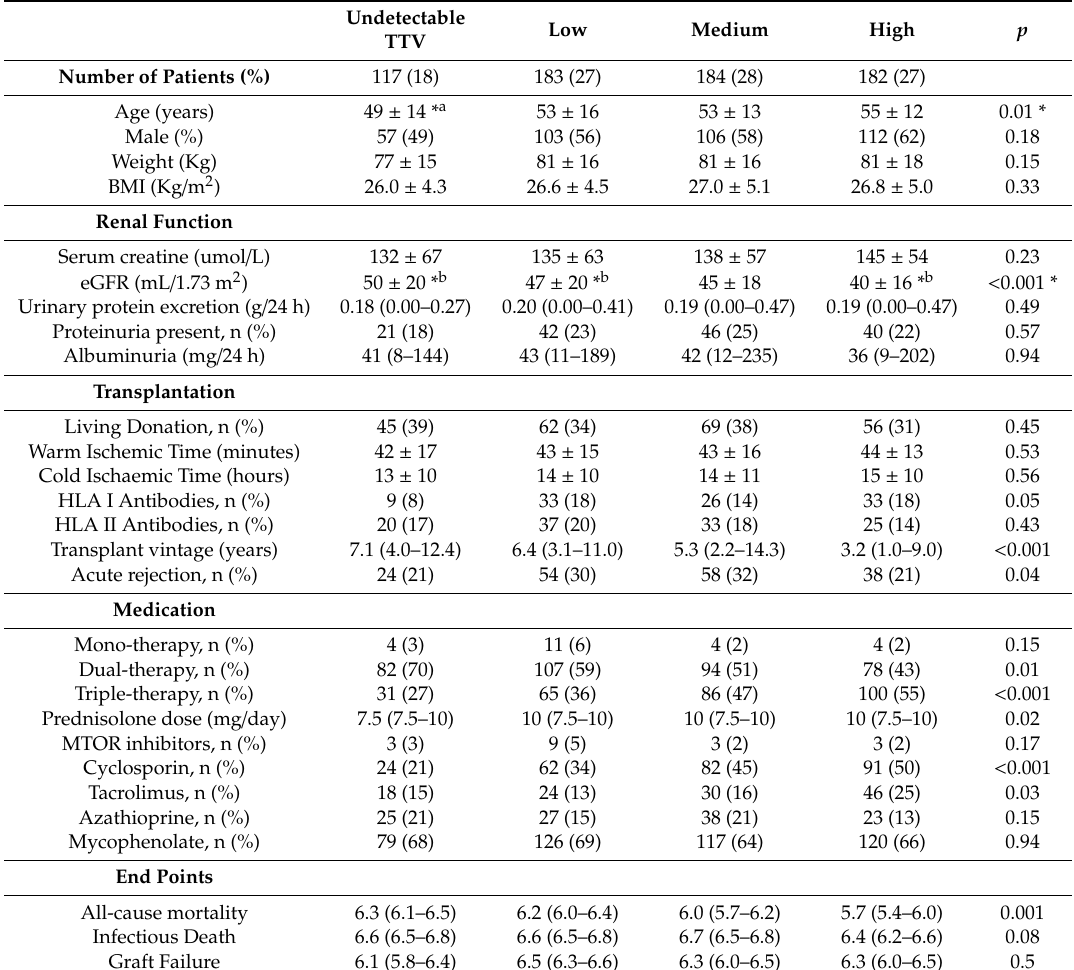
Table 1. Recipient